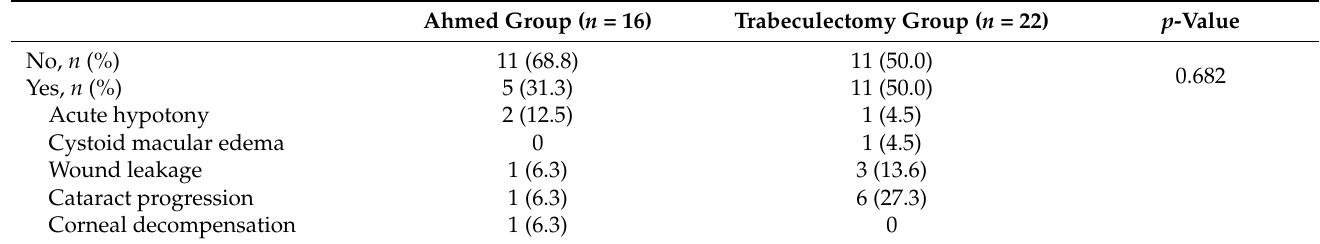
Table 4. Comparison of surgical complications between Ahmed and trabeculectomy